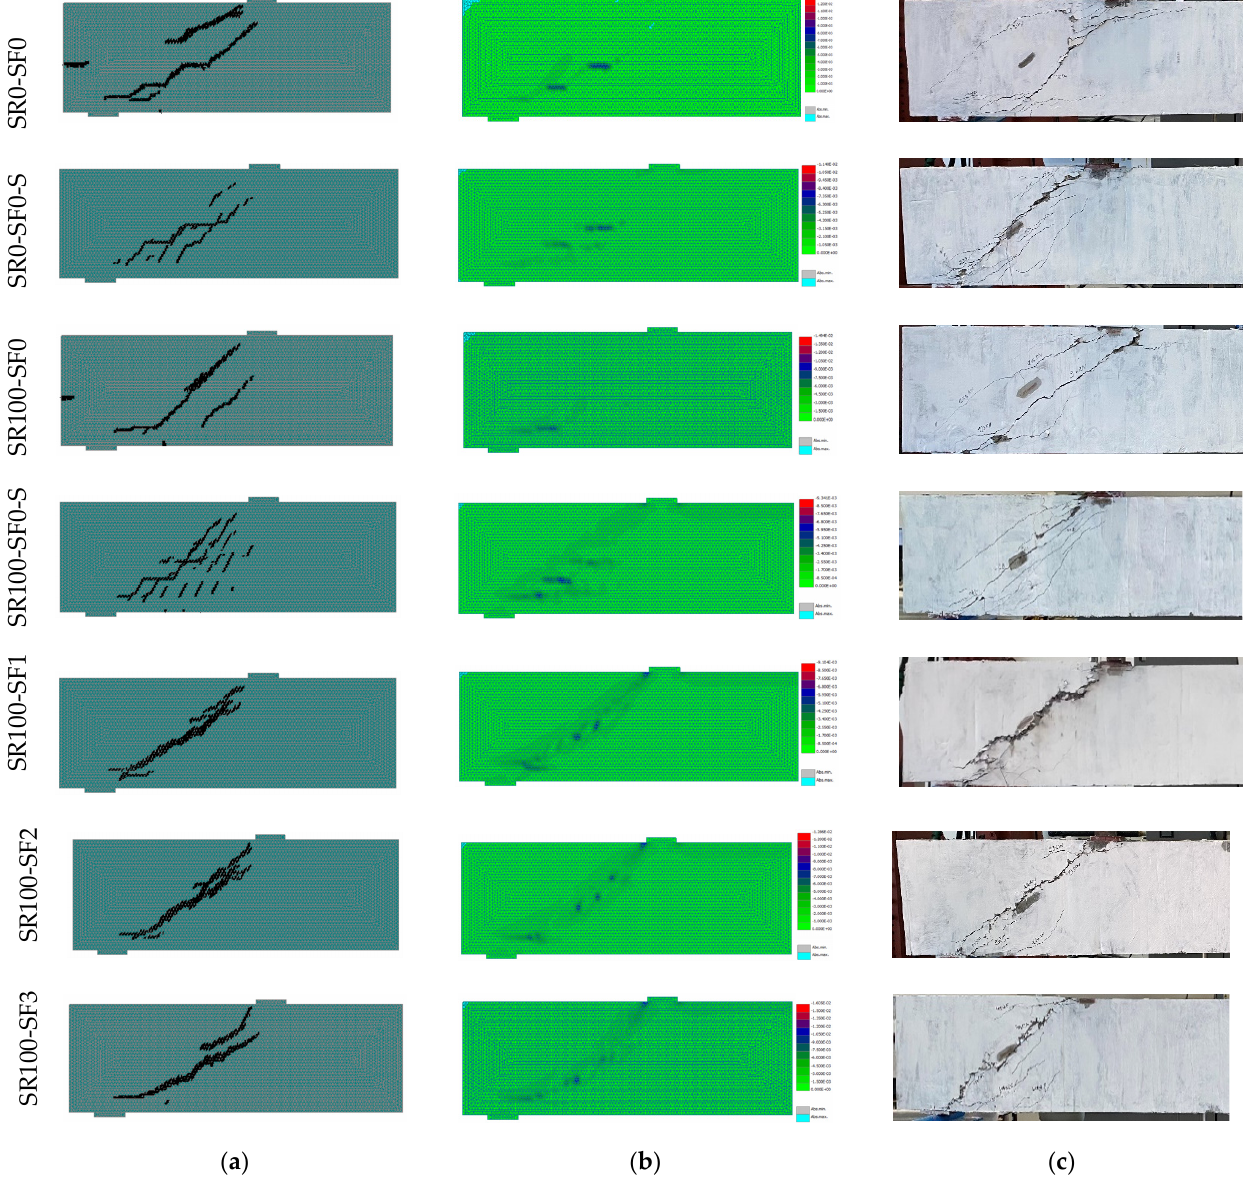
Figure 9. Crack patterns and principal strains of group S: ( a ) numerical crack patterns; ( b ) minimum principal strains; and ( c ) experimental crack patterns.